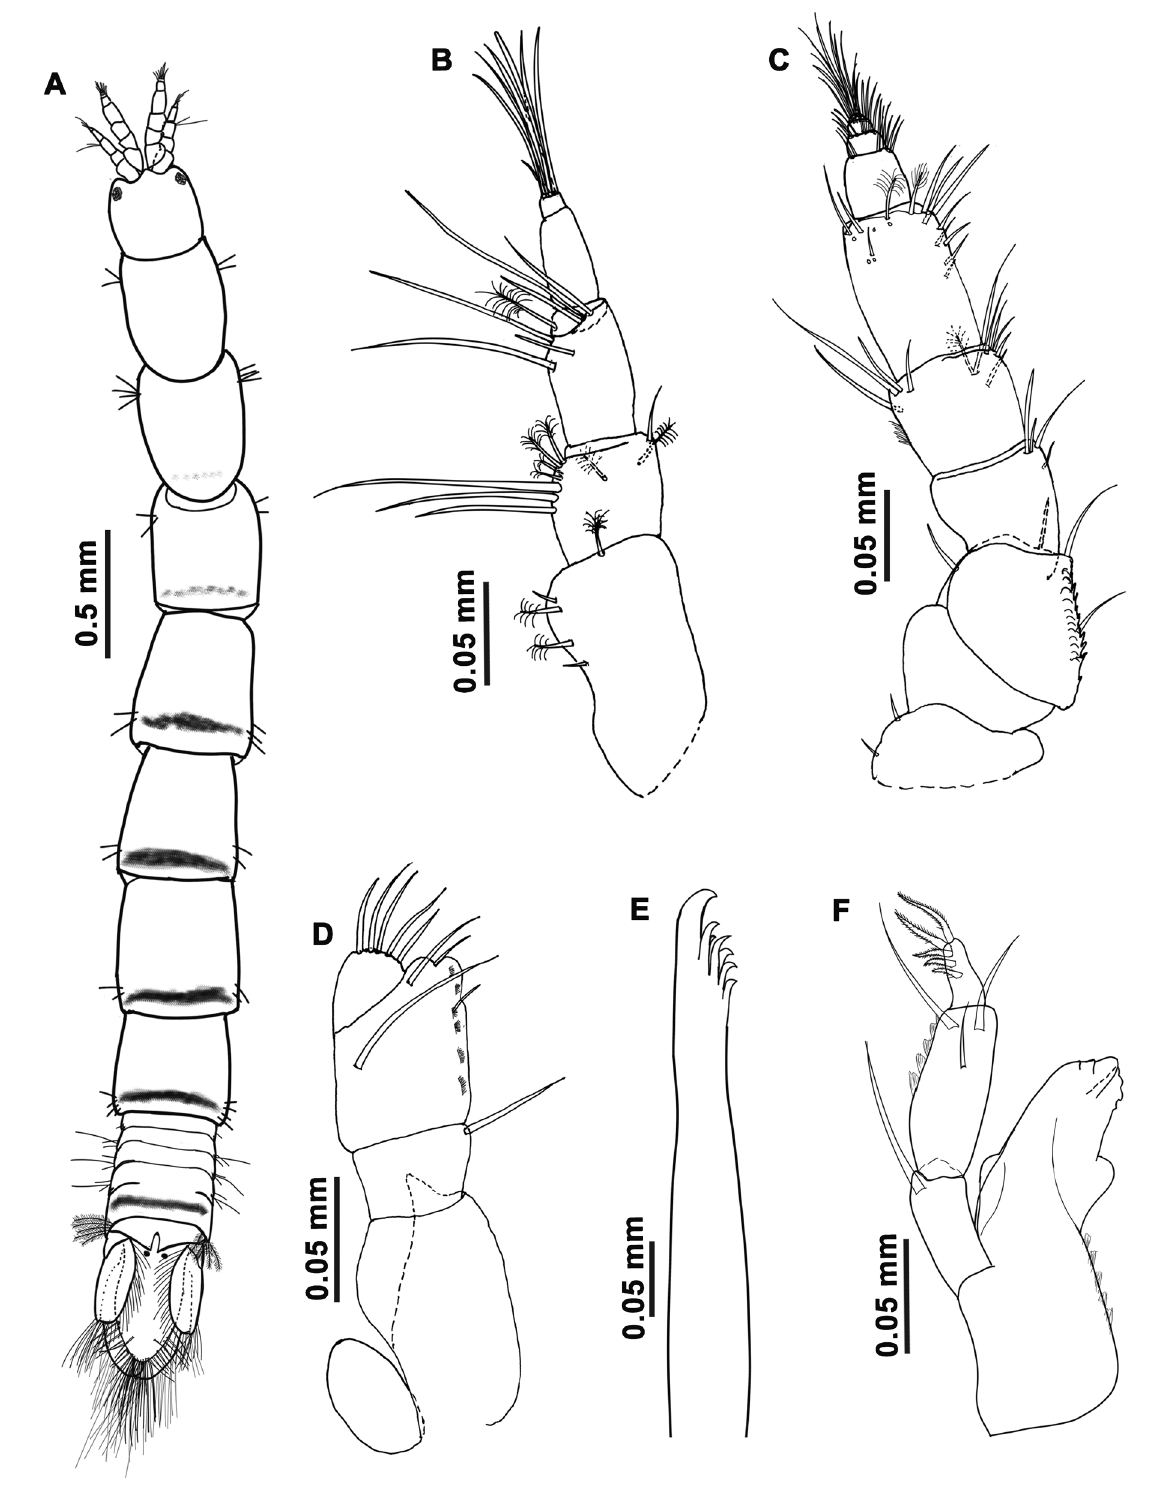
Fig. 2. Amakusanthura guerrerensis sp. nov., holotype, ♀, 5 mm, Guerrero, Ixtapa Island, Coral Beach (UMAR-PERA 522). A . Habitus. B . Antennule. C . Antenna. D . Maxilliped. E . Maxilla. F . Mandible